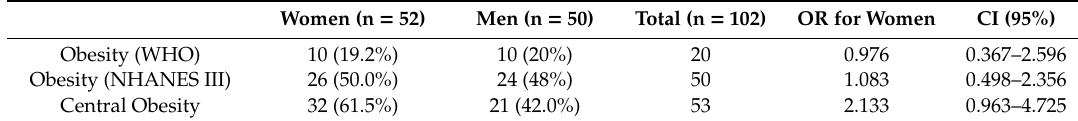
Table 2. Modes of obesity between women and men (n (%)).